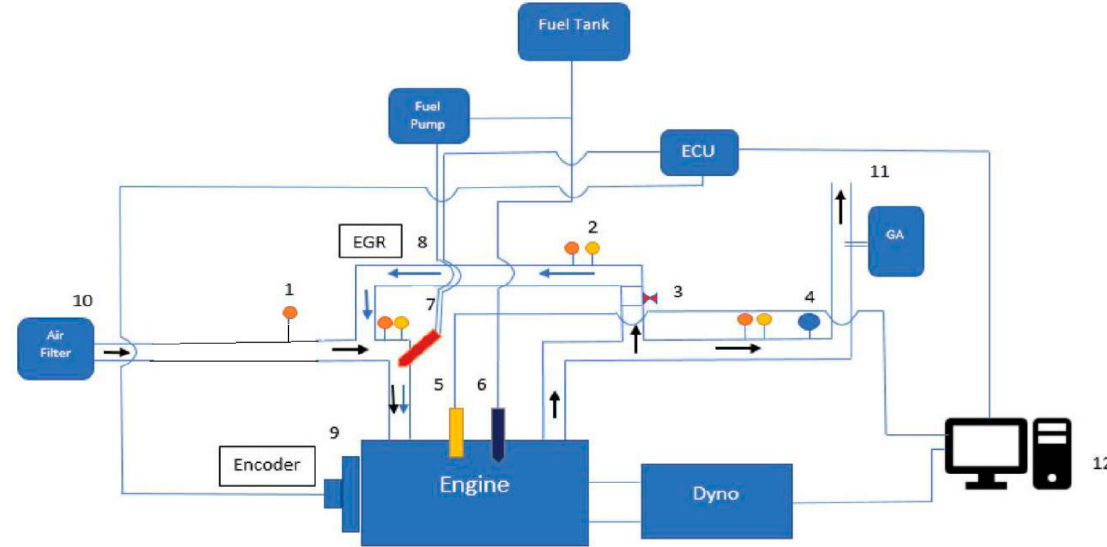
Figure 1. Schismatic diagram of engine test rig: (1) Thermocouple, (2) Pressure sensor, (3) EGR valve, (4) Oxygen sensor, (5) In-cylinder pressure, (6) Direct injection, (7) Port injection, (8) Exhaust gas recirculated system, (9) Encoder, (10) Opening intake air, (11) Opening exhaust air, (12) PC.